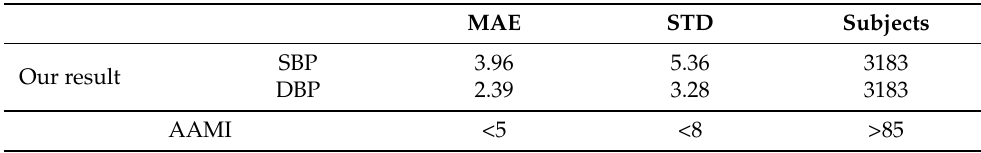
Table 3. Comparison result with AAMI Standard.